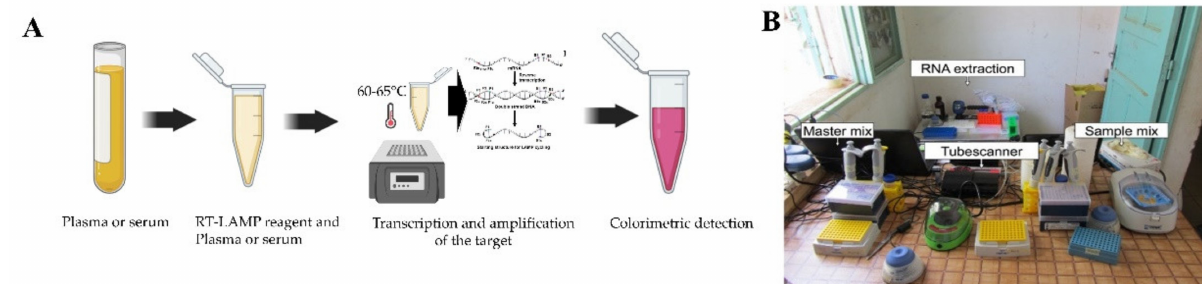
Figure 4. Detection of DENV RNA using isothermal amplification based platforms. ( A ) Detection of DENV RNA using LAMP method, initially RNA is transcripted to dsDNA and then amplified by the primers creating a loop structure (Modified from [107]). ( B ) A mobile laboratory to be used at point of care to detect DENV using RPA method utilizing minimal reagents as well as equipment (reprinted from